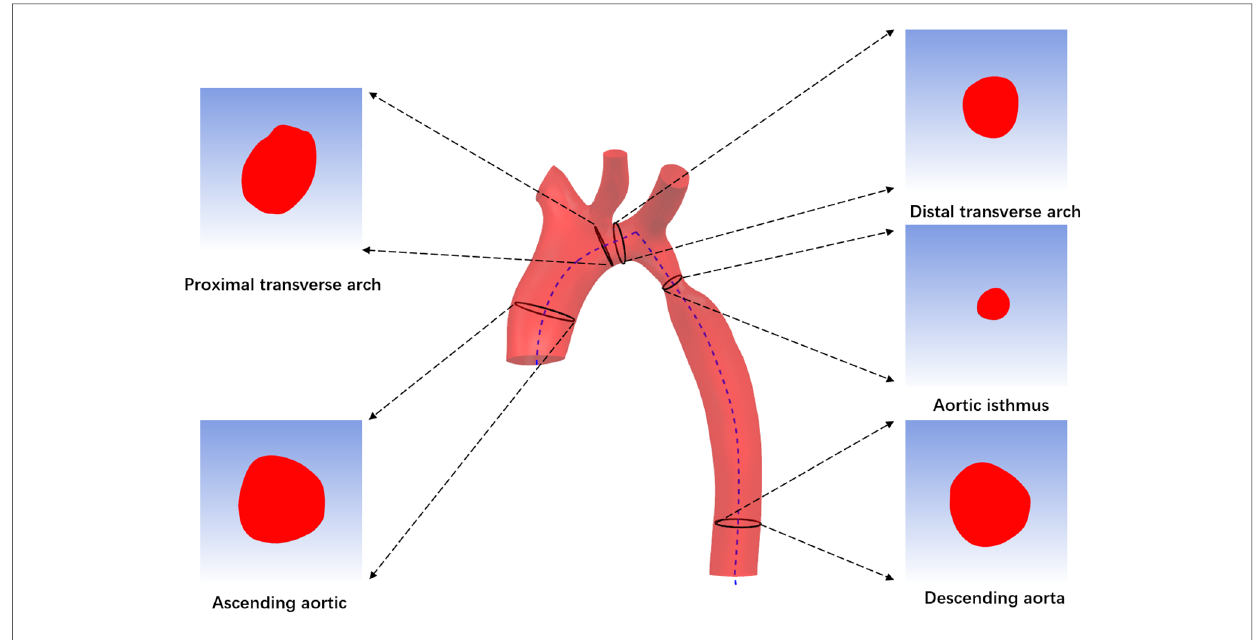
FIGURE 3 Acquisition of image data.